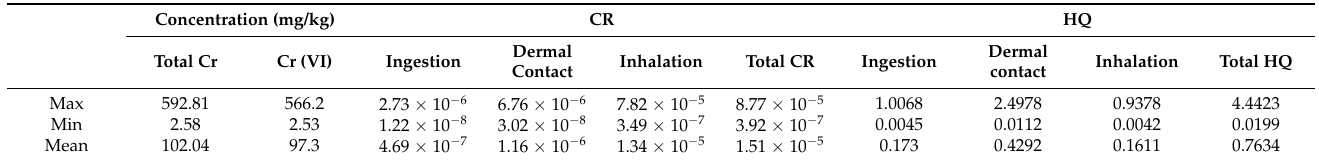
Table 1. Total Cr and Cr(VI) concentrations, carcinogenic and non-carcinogenic risks in soil samples from chemical plants in the study area in 2019. Table 2. Total Cr and Cr(VI) concentrations, carcinogenic and non-carcinogenic risks in groundwa- ter samples from the study area at different periods.